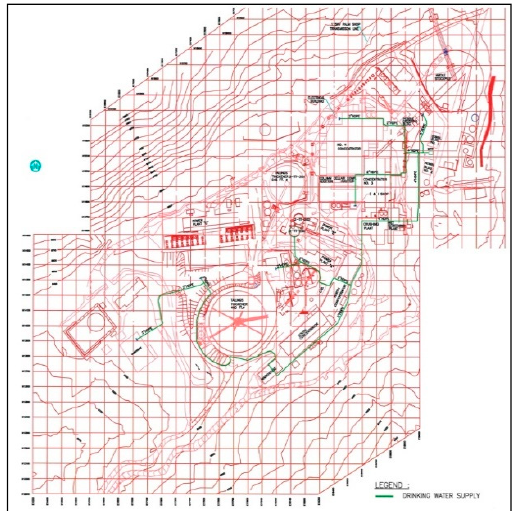
Figure 1. Case study area of the main water distribution line.